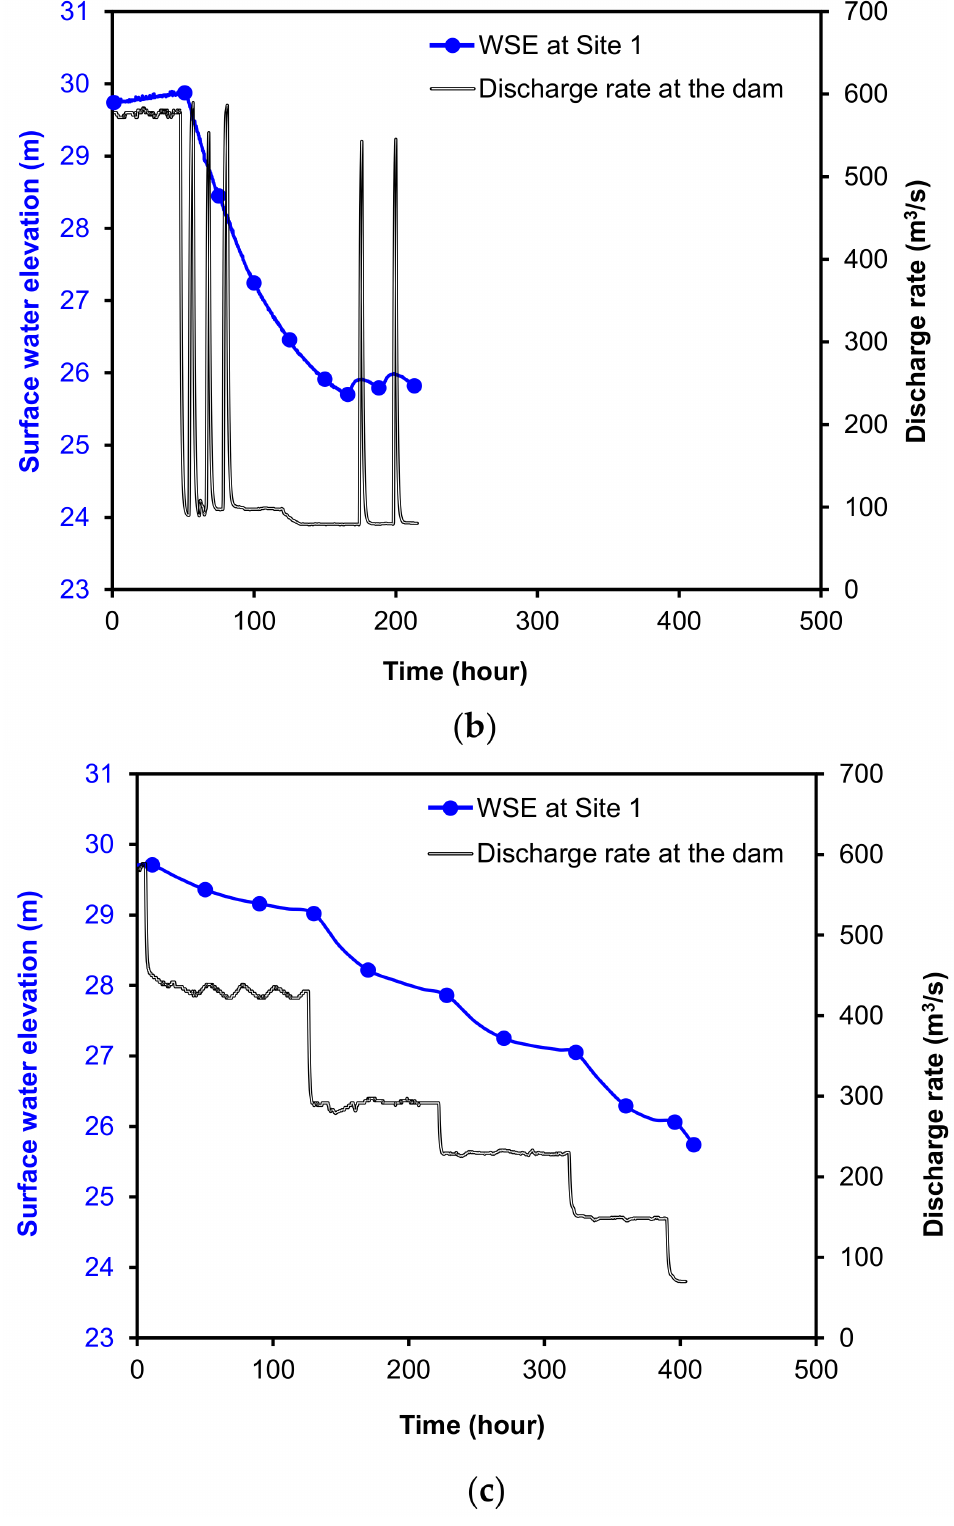
Figure 7. Actual discharge patterns and corresponding monitored changes of WSE at Site 1: ( a ) peaking; ( b ) drawdown; ( c )